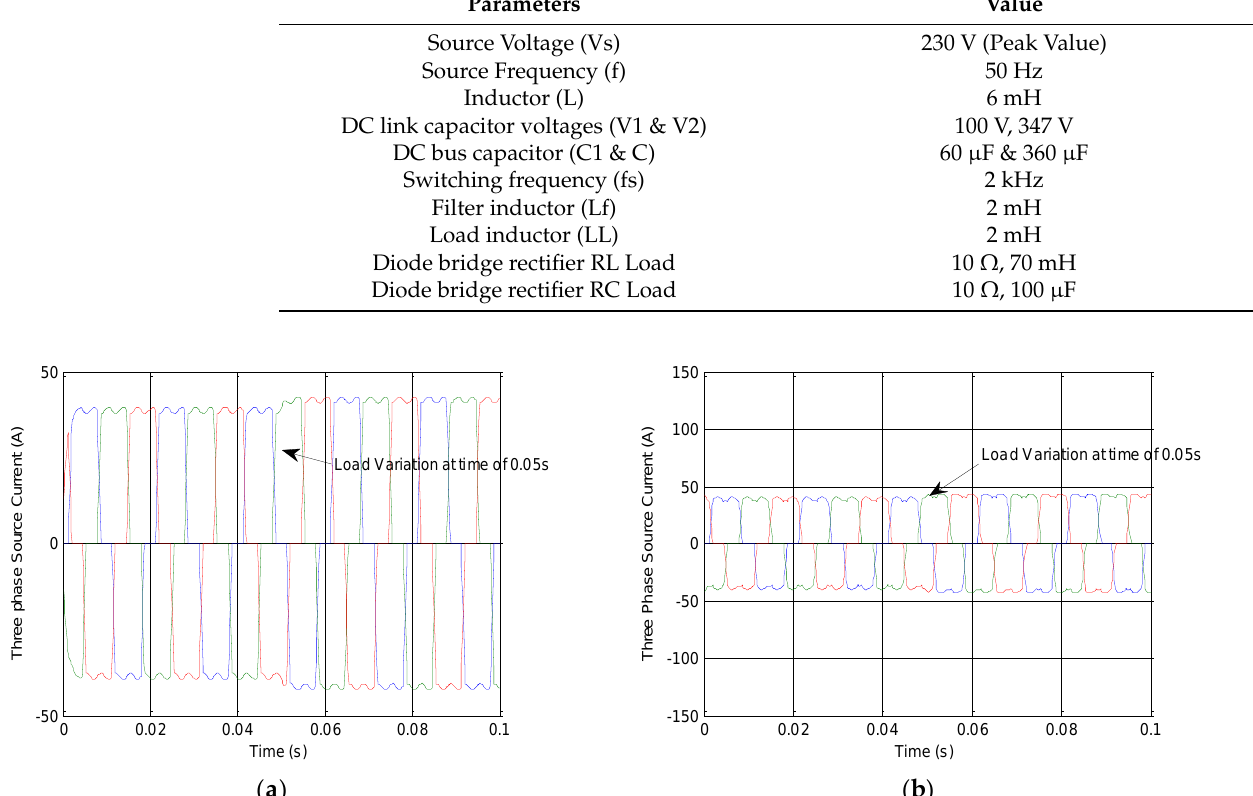
Figure 6. Simulation of experimental conditions employed in this study.